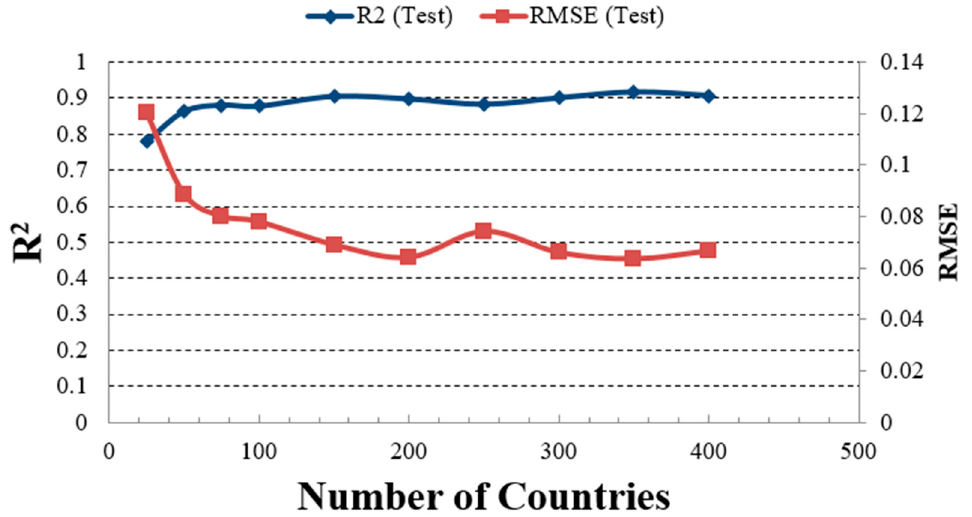
Figure 8. PIs Changes for testing section.